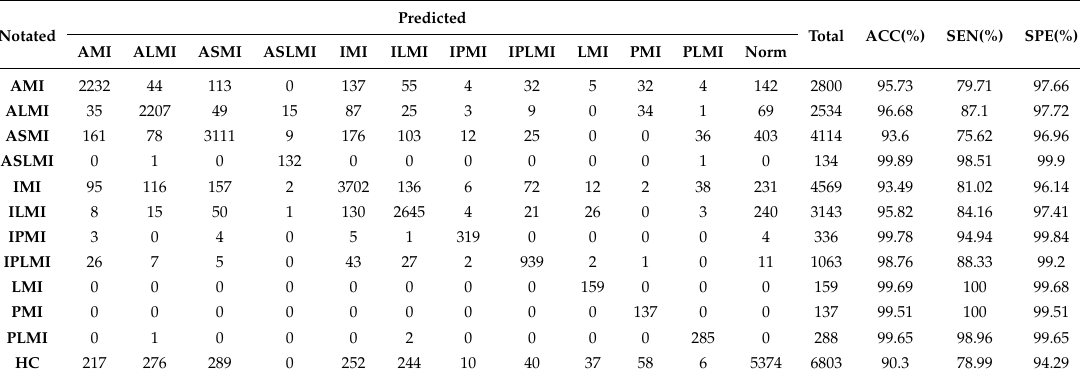
Table 6. Confusion matrix for MI classification using derived Frank Y